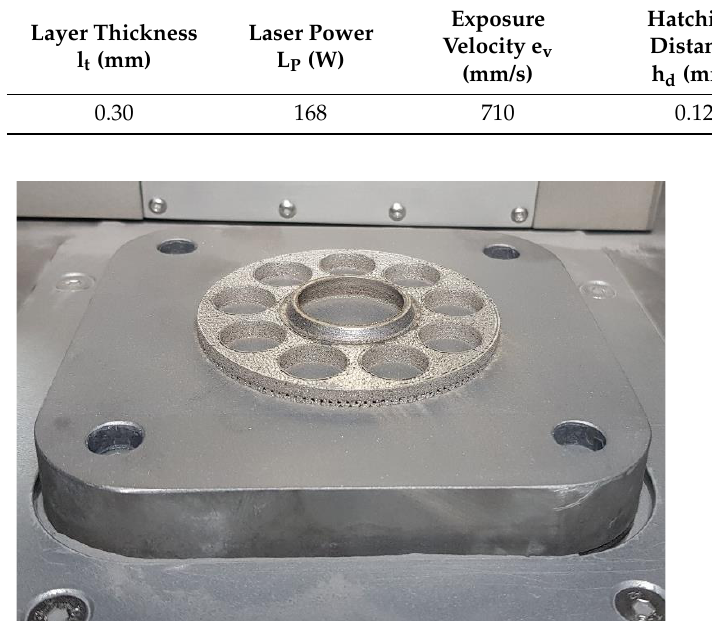
Figure 3. The slipper- retainer test part on the device’s building platform .